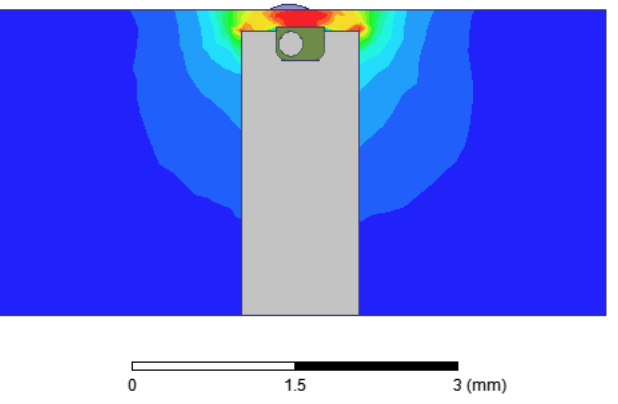
Figure 15. Field distribution in case 4, on the cross-section where the pinis shorted to the ridge. The ridge and the pin are displayed in gray, and the EPO-TEK H20E in green. The pin misalignment and its non-direct contact with the ridge does not affect the TE 10